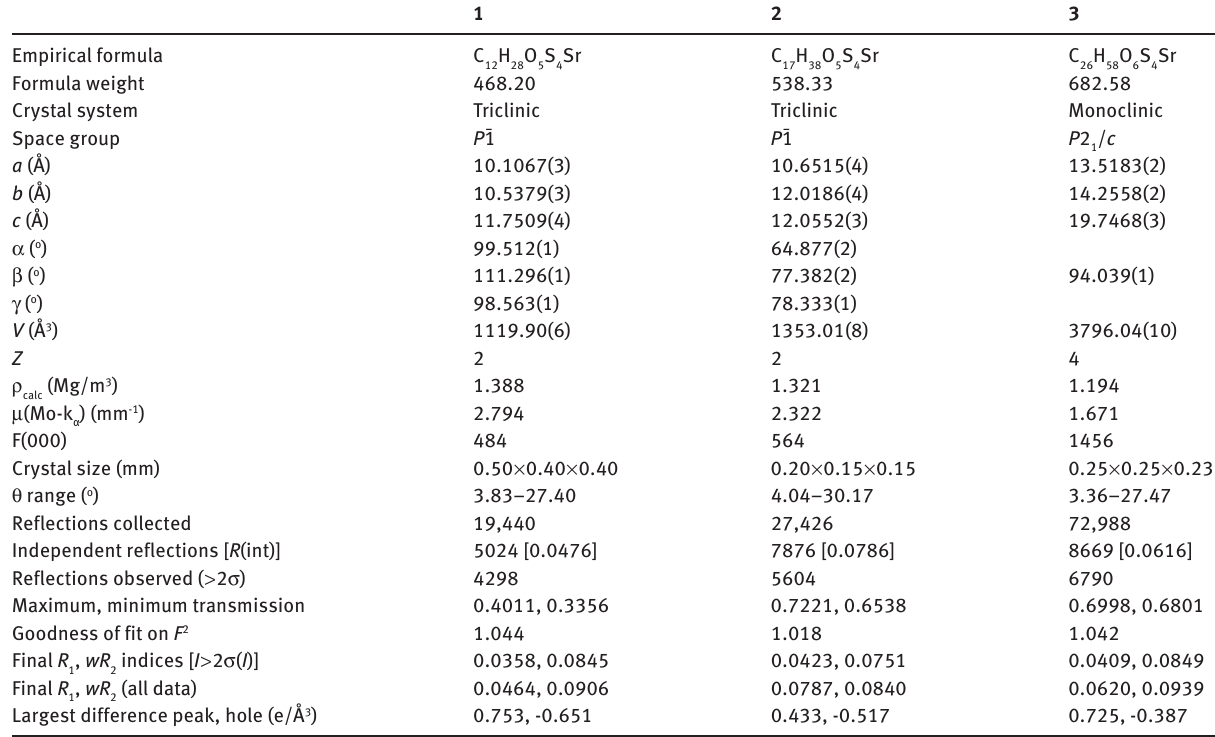
Table 3 Crystal data and structure refinement for compounds 1 –